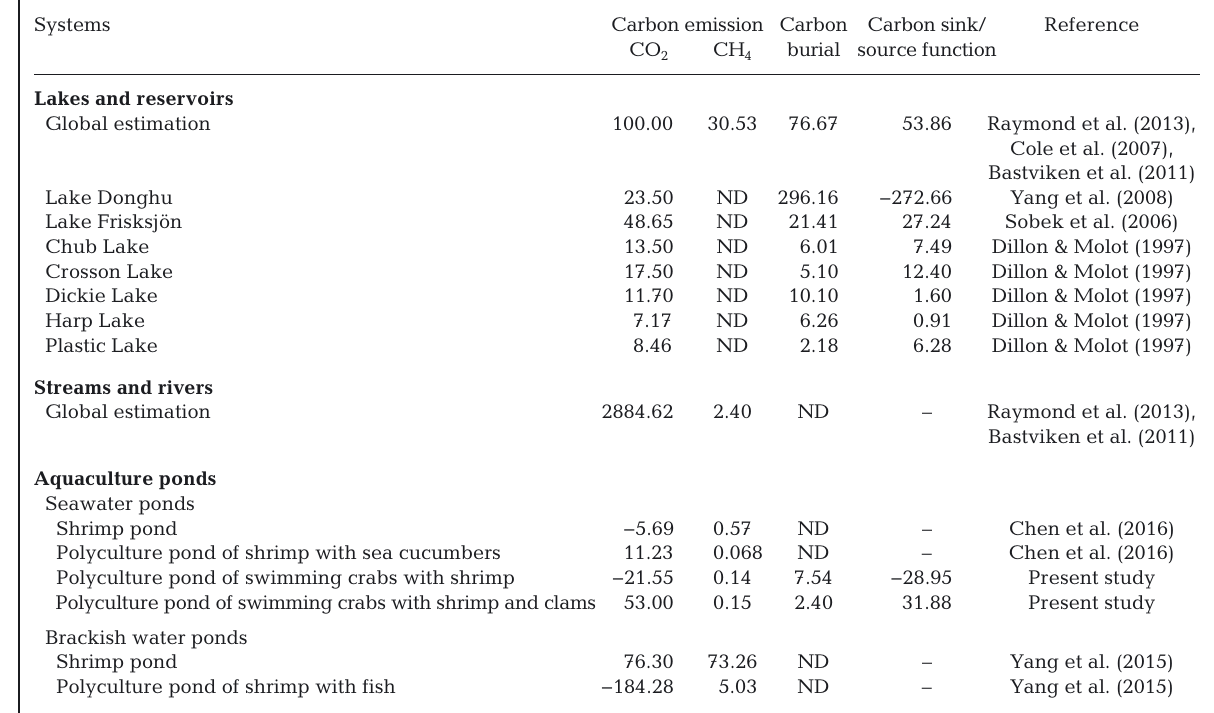
Table 5. Annual carbon emissions and burial rates in different aquatic systems (g m −2 ). Positive values in carbon emissions in- dicate carbon emissions from aquatic systems, while negative values indicate carbon absorption by aquatic systems at the water−air interface. Positive values in carbon sink/source function indicate a carbon source function, while negative values indicate a carbon sink function. ND: no